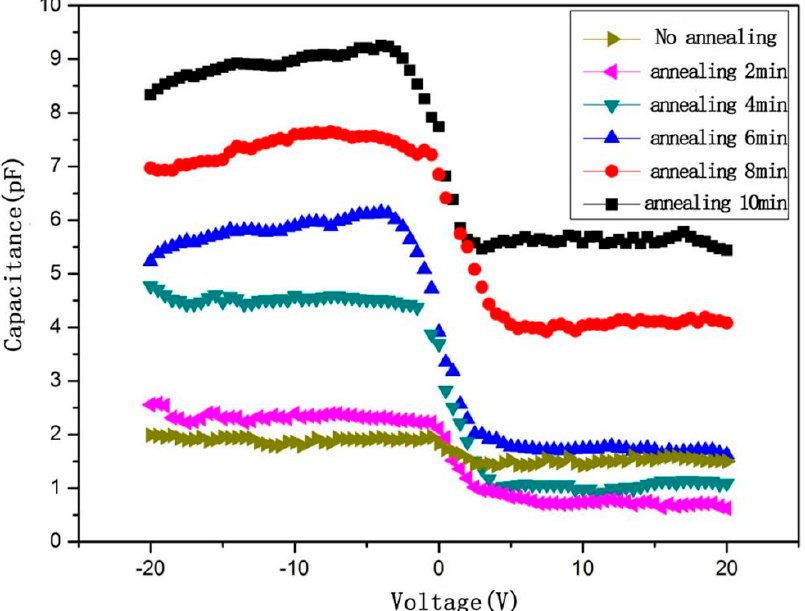
Figure 9. The C–V curves of the Ti-Au/CdZnTe samples annealed at 423 K in an Ar atmosphere for different times. Table 6. The barrier heights of Ti-Au/CdZnTe annealed at 423 K for different times.